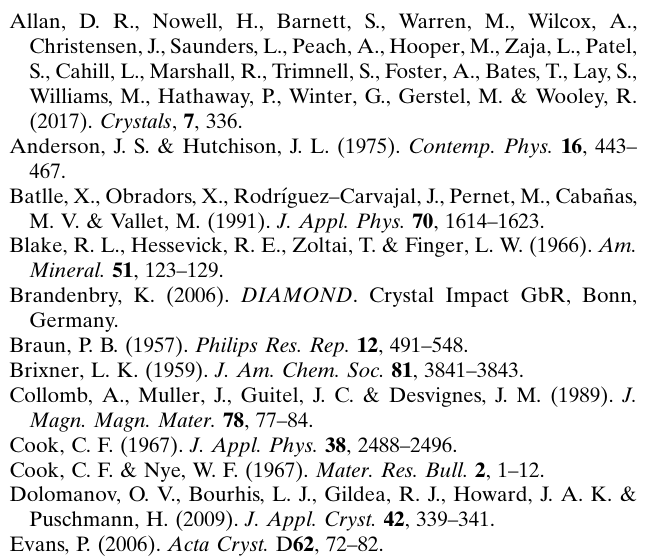
Table 9 Zinc force-field parameters from the work by Lewis et al.